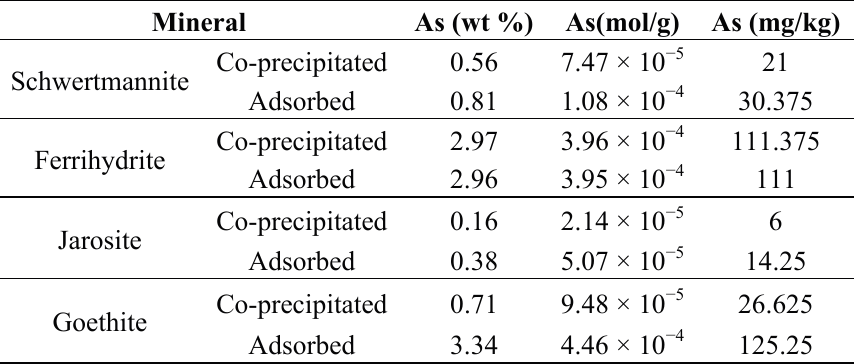
Table 2. Arsenic load in minerals used for this study.